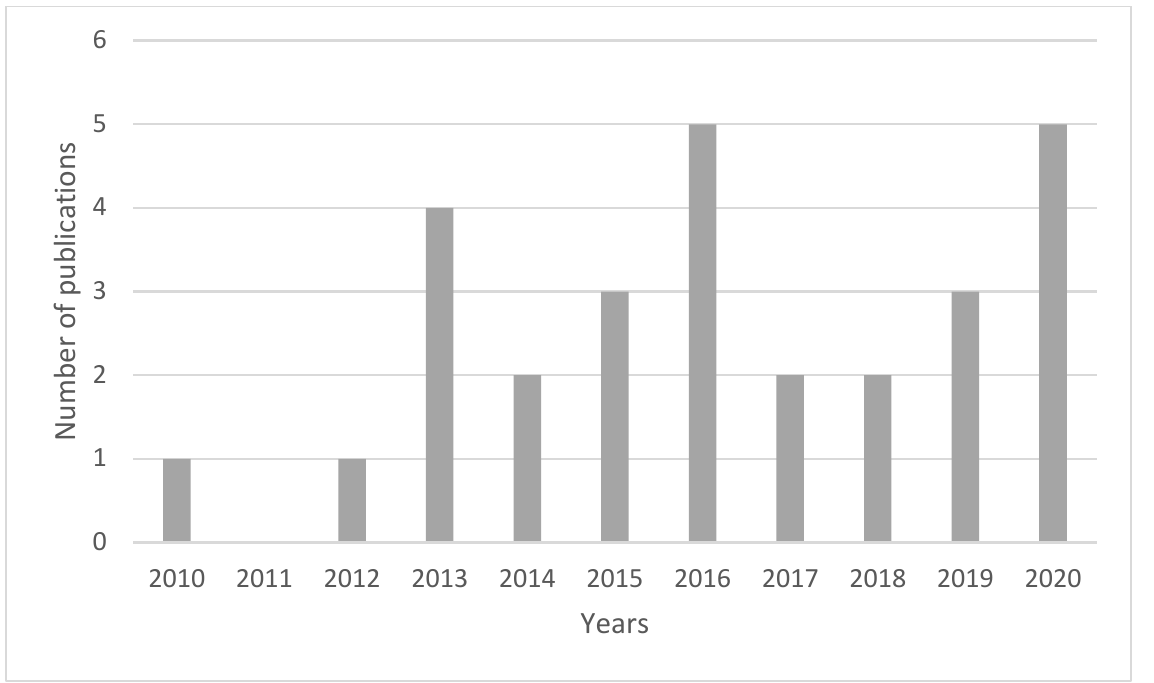
Figure 1. Studies according to the publication year.